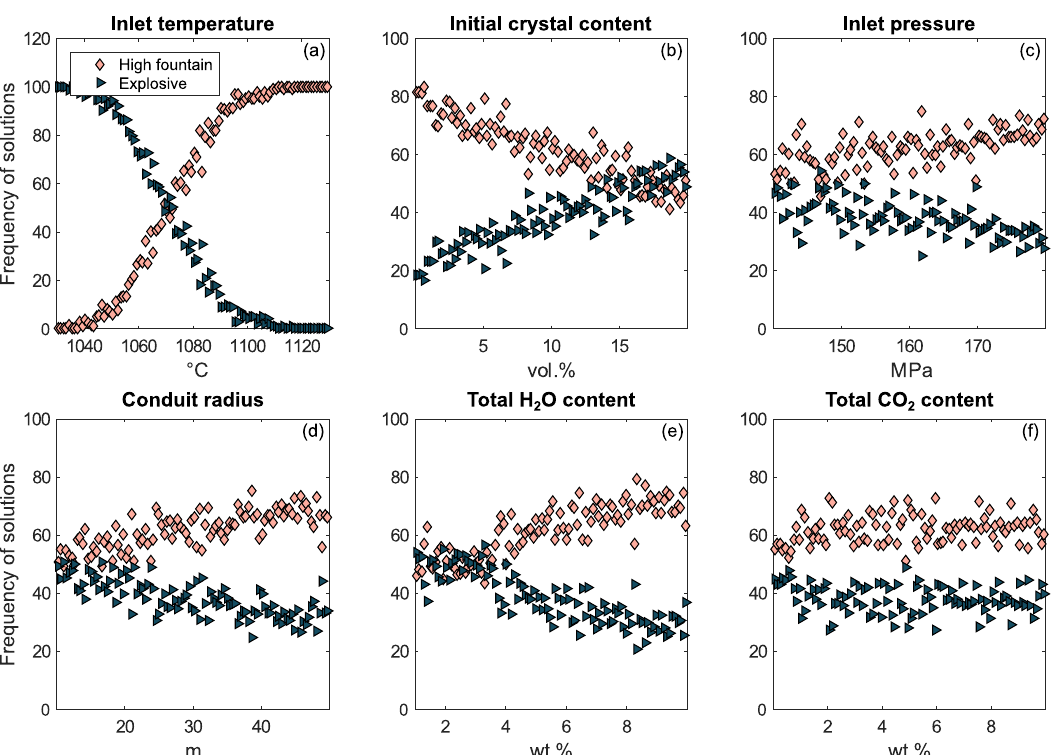
Fig. 3 Frequency of solutions as function of each input parameter resulting from the sensitivity analysis. We plot the number of solutions obtained from the sensitivity analysis as function of the input parameters: ( a ) the inlet temperature; ( b ) the initial crystal content (i.e. phenocryst content); ( c ) inlet pressure; ( d ) conduit radius; ( e ) total H 2 O content; ( f ) total CO 2 content. Results are normalised as a percentage such that the sum of frequencies is always 100. Of all the 10,000 simulations performed, ~7% (mostly at low inlet temperature and low total water content) were not able to satisfy the boundary conditions at the vent of the conduit (i.e. magma is not able to reach the surface), resulting in unacceptable solutions. Since there is still a signi fi cant amount of acceptable simulations (~93%), the sensitivity analysis has not been affected by this issue. The eruptive styles are distinguished following La Spina et al. 41 . An “ explosive ” simulation (dark green triangles) is obtained when fragmentation is achieved below the vent of the conduit. If fragmentation is not met within the conduit, then ballistic jet height H = u 2 /(2 g) is calculated. If H > 50 m then the simulation is marked as “ high fountain ” (pink diamonds); if 0.1 < H < 50 m as “ weak fountain ” ; if H < 0.1 m as “ effusive ”